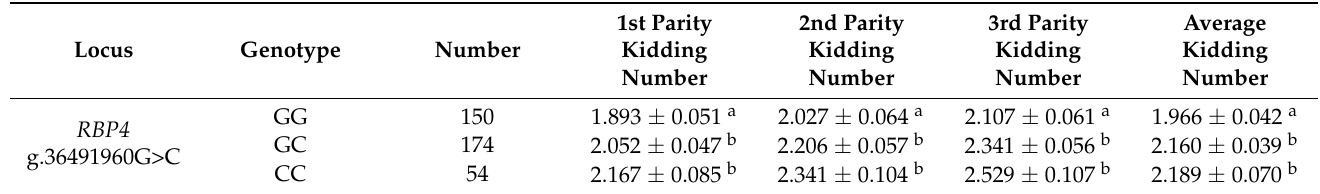
Table 5. Least-squares means and standard errors of kidding number in Yunshang black goats with different genotypes.